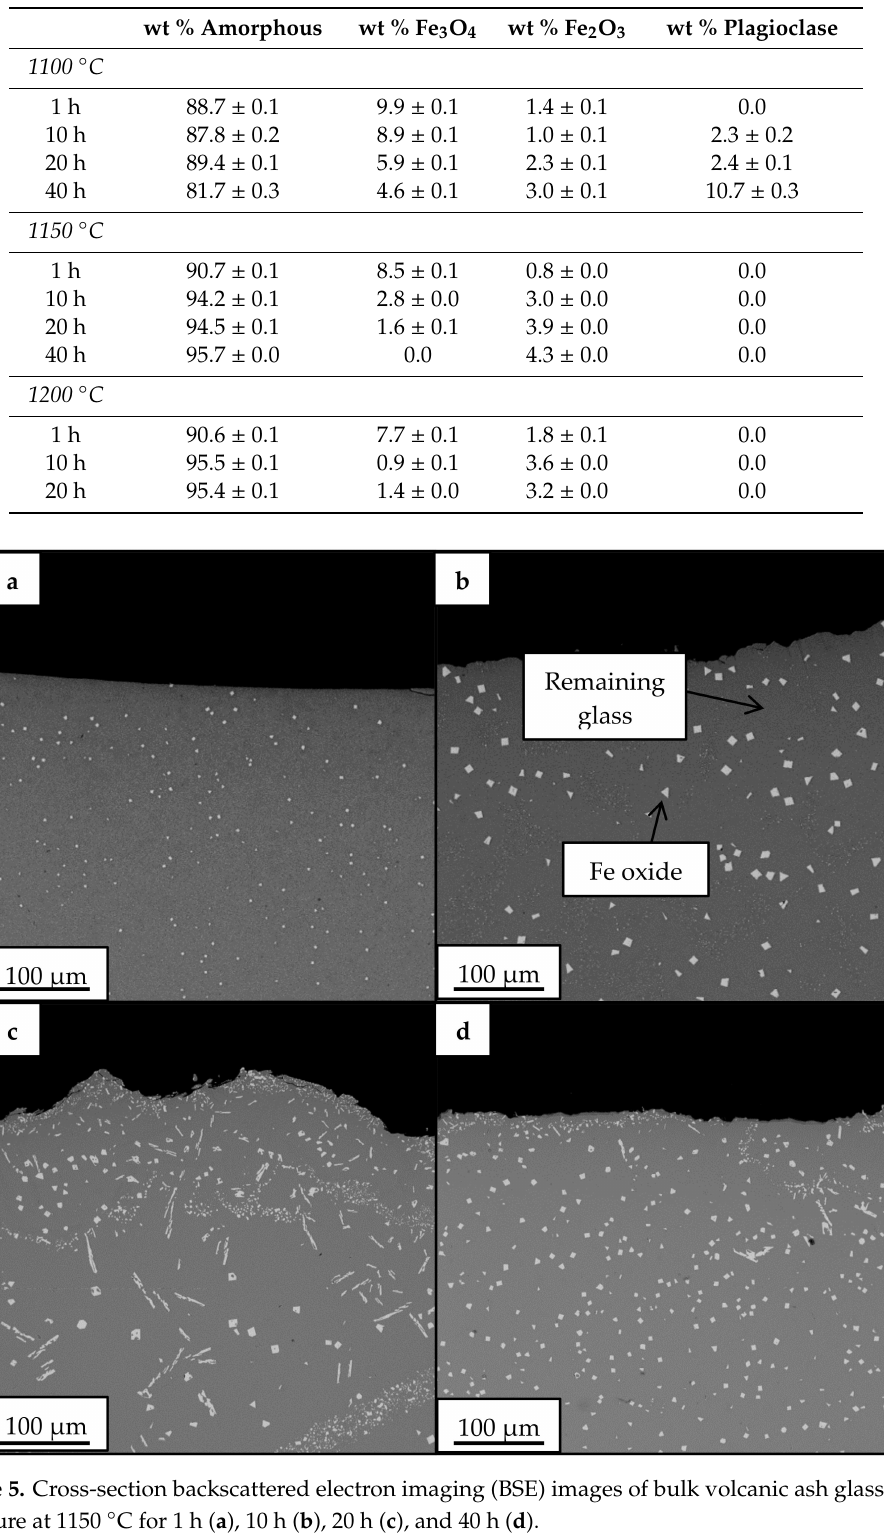
Table 3. The phase composition of bulk volcanic ash glass samples after heat treatment using quantitative XRD analysis.